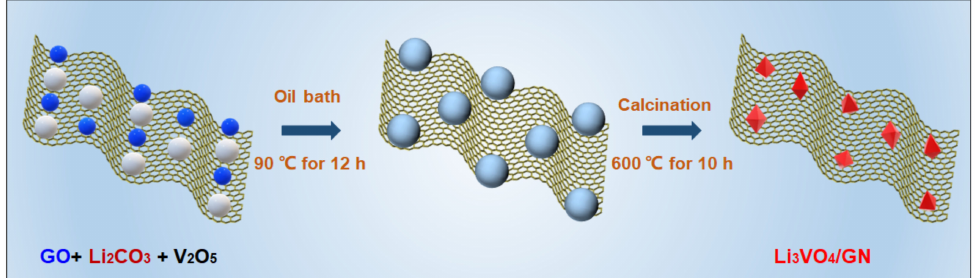
Figure 1. Schematic illustration of LVO/GN composite